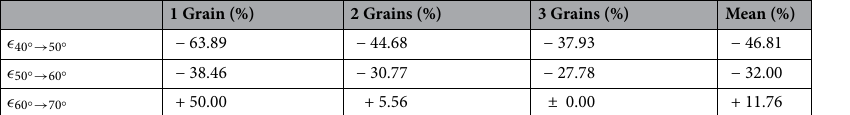
Table 4. Relative difference of MSEs for reconstructions when adding 10 ◦ for ψ max of 40 ◦ , 50 ◦ and 60 ◦ for pole plots with different numbers of grains.